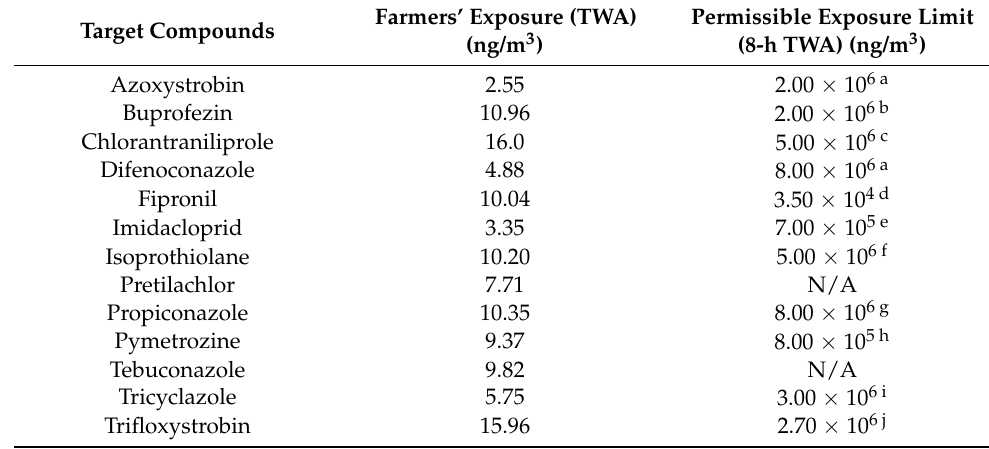
Table 5. Pesticide’s exposure and permissible exposure limit (PEL) of farmers ( n =